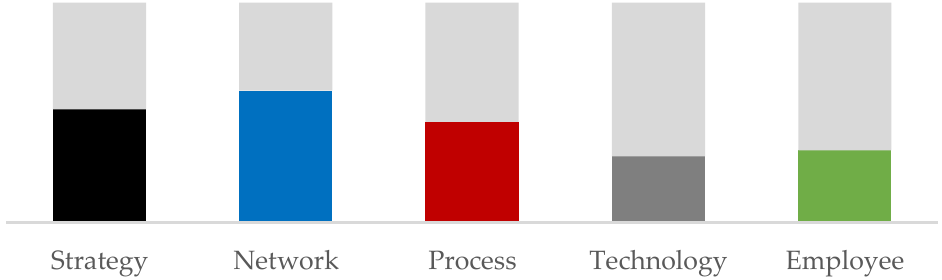
Figure 11. Level of the five logistics dimensions for the balanced intermediate profile.